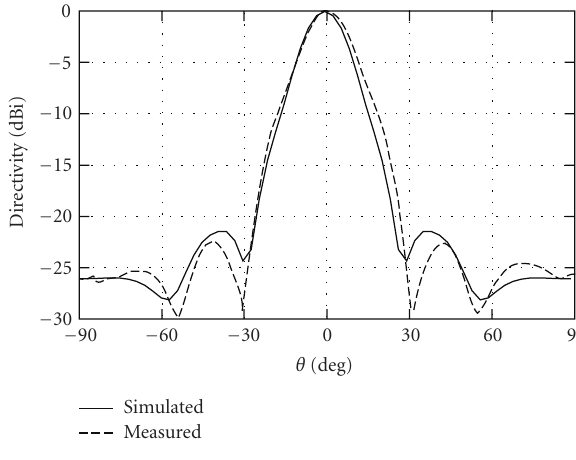
Figure 7: Radiation patterns at 5.3 GHz (H-plane).